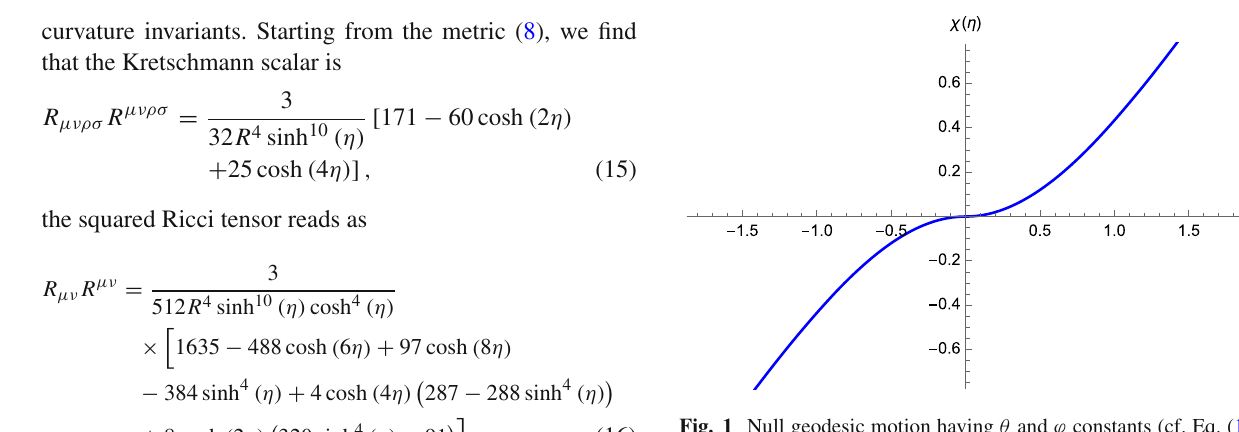
Fig. 1 Null geodesic motion having θ and ϕ constants (cf. Eq. (19)). It is clear that the function χ(η) is continuous at the BB